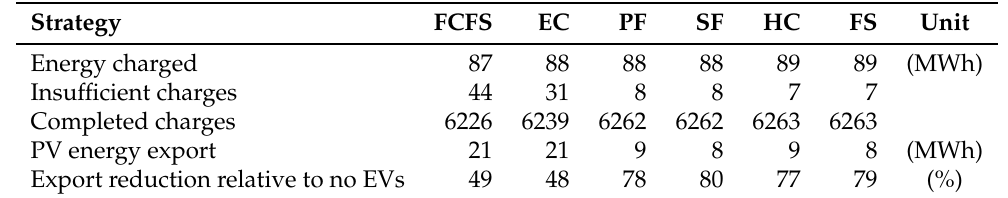
Table 2. Simulation results for the smart charging strategies for 30 employees. Shown are the results of implementing the respective strategy only. Exported energy reduction is calculated relative to no-EV case, where 40 MWh is exported to the grid.